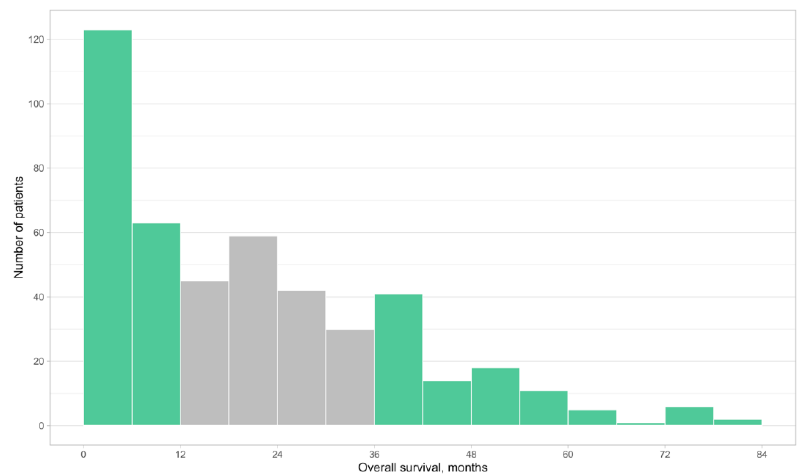
Figure 1. Histogram demonstrating pattern of survival in patients surviving <1 year and >3 years (in green). Patients who survived beyond 1 year but under 3 years are represented in grey (not included in the main study).